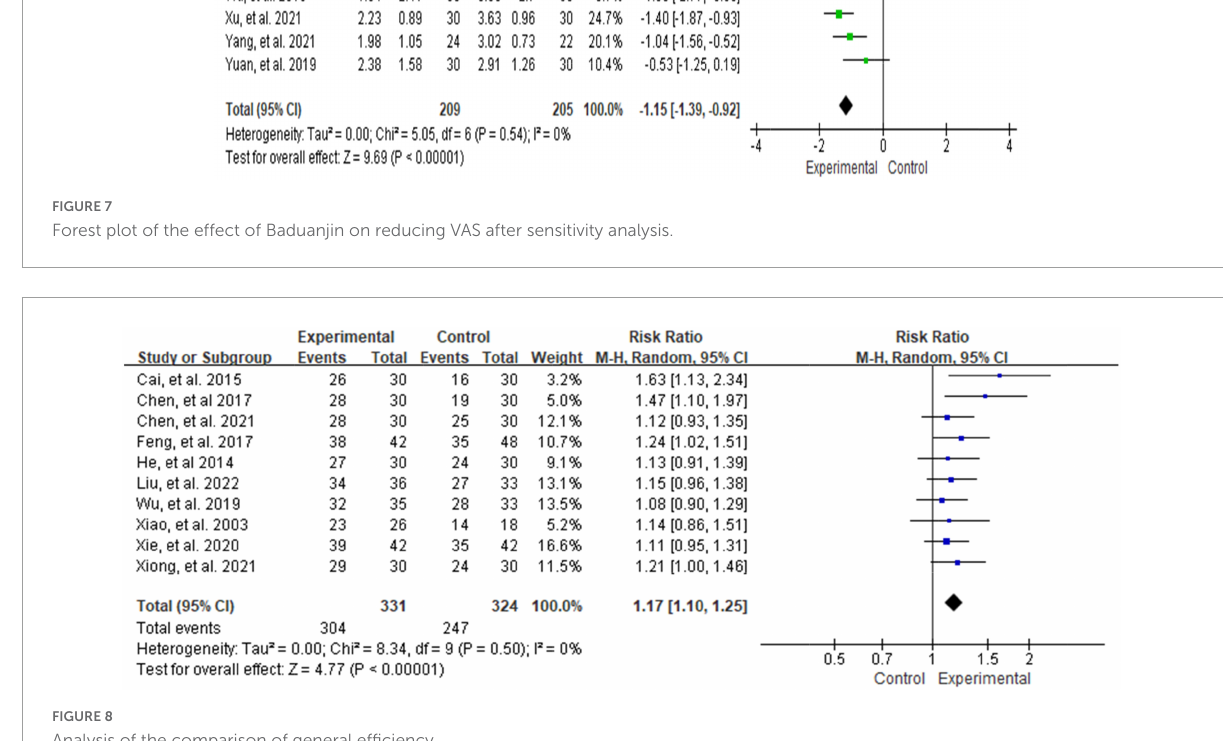
FIGURE8 Analysis of the comparison of general